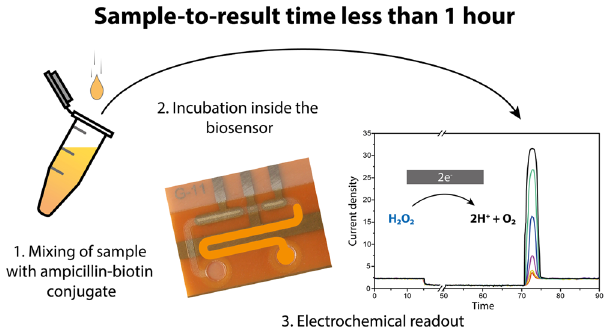
Figure 3. Illustration of a bedside monitoring scenario. After the sample is extracted from the patient, it is mixed with the ampicillin-biotin conjugate (1.) and incubated in the biosensor’s immobilization section (2.). After applying the avidin-GOx enzyme, the electrochemical read-out of the sensor completes the measurement (3.), resulting in an allover sample-to-result time of less than 1